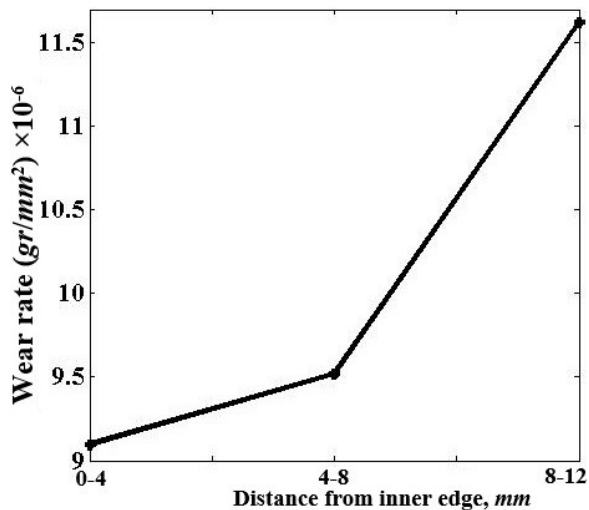
Figure 11: Variation of the Wr along the radial direction from inner to outer walls of thick FGM cylindrical shell under fixed normal load ( F N ) of 40 KN at linear sliding velocity ( S V ) of 6.35 :cm/s and sliding distance ( S m ) of ~440